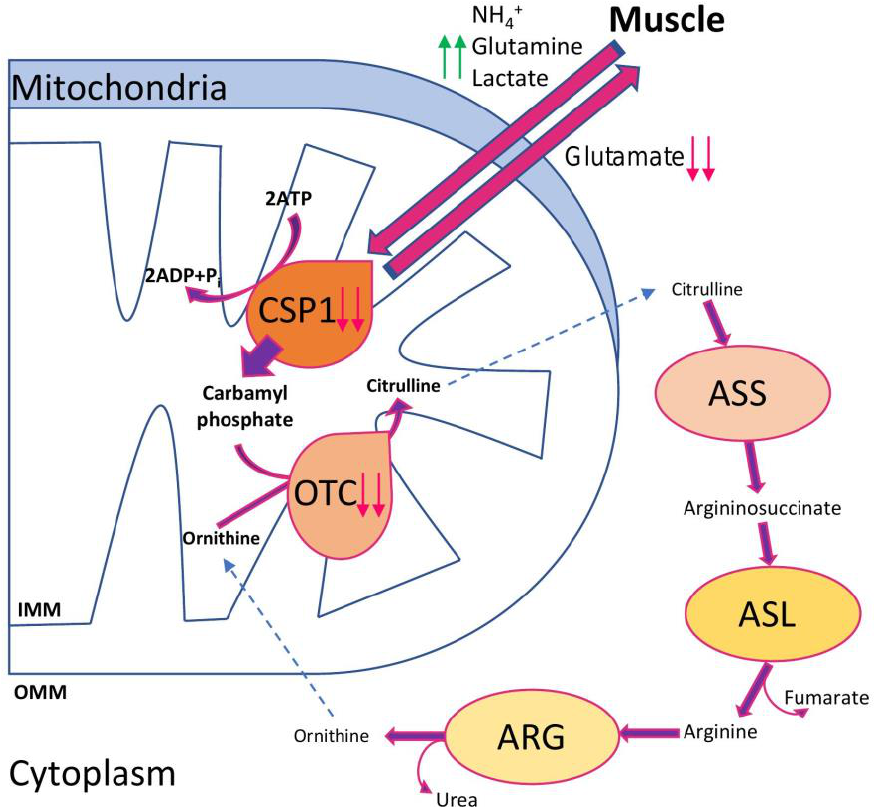
Figure 1. Involvement of the liver mitochondria in ammonia detoxification. Under NAFLD/NASH conditions, the expression and activities of CSP1 and OTC enzymes are reduced (magenta arrows) and the efficiency of the urea cycle is diminished, which leads to hyperammonemia (green arrows) and activation of pro-fibrotic and pro-inflammatory factors favoring the disease progression.